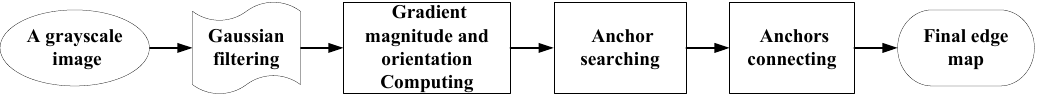
Figure 3. Flowchart of the edge drawing (ED) process.